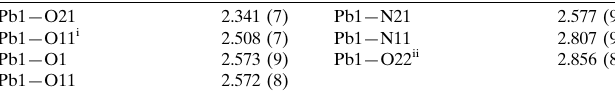
Selected bond lengths (A˚ ).